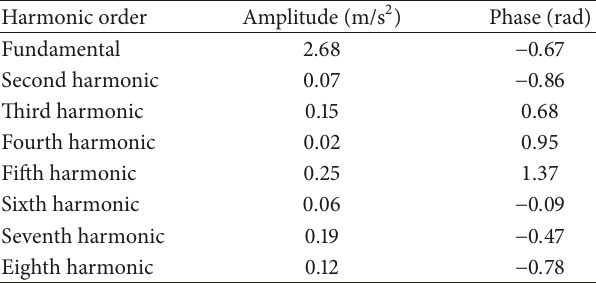
Table 2: The estimated amplitude and phase.